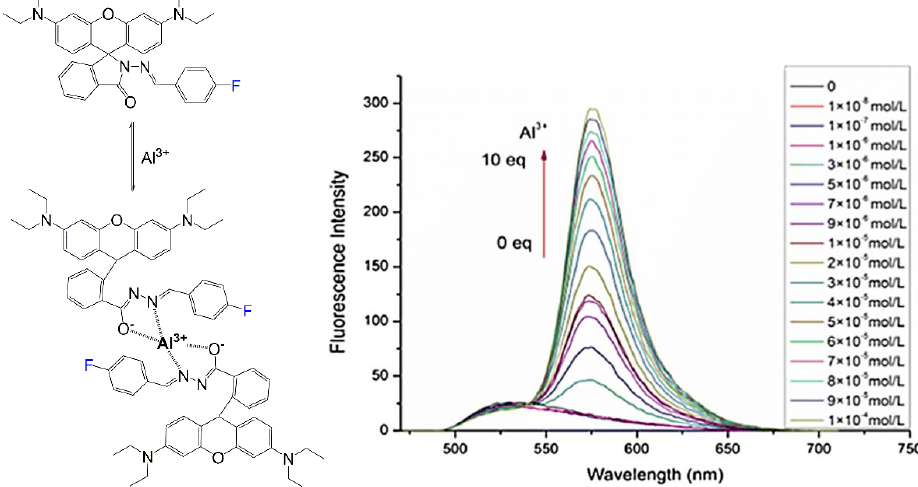
Figure 10. Metal sensing rhodamine dye 37 , selectivity for aluminum ions [43]. Binding mode in the presence of aluminum ion ( left ), and fluorescence emission spectra ( right ) at increasing concentra- tions of aluminum ion (0 – 10 equivalents) with 1 × 10 −5 M of compound 37 in ethanol solution. Figure used with permission from [43]. Copyright 2019 Springer Nature.